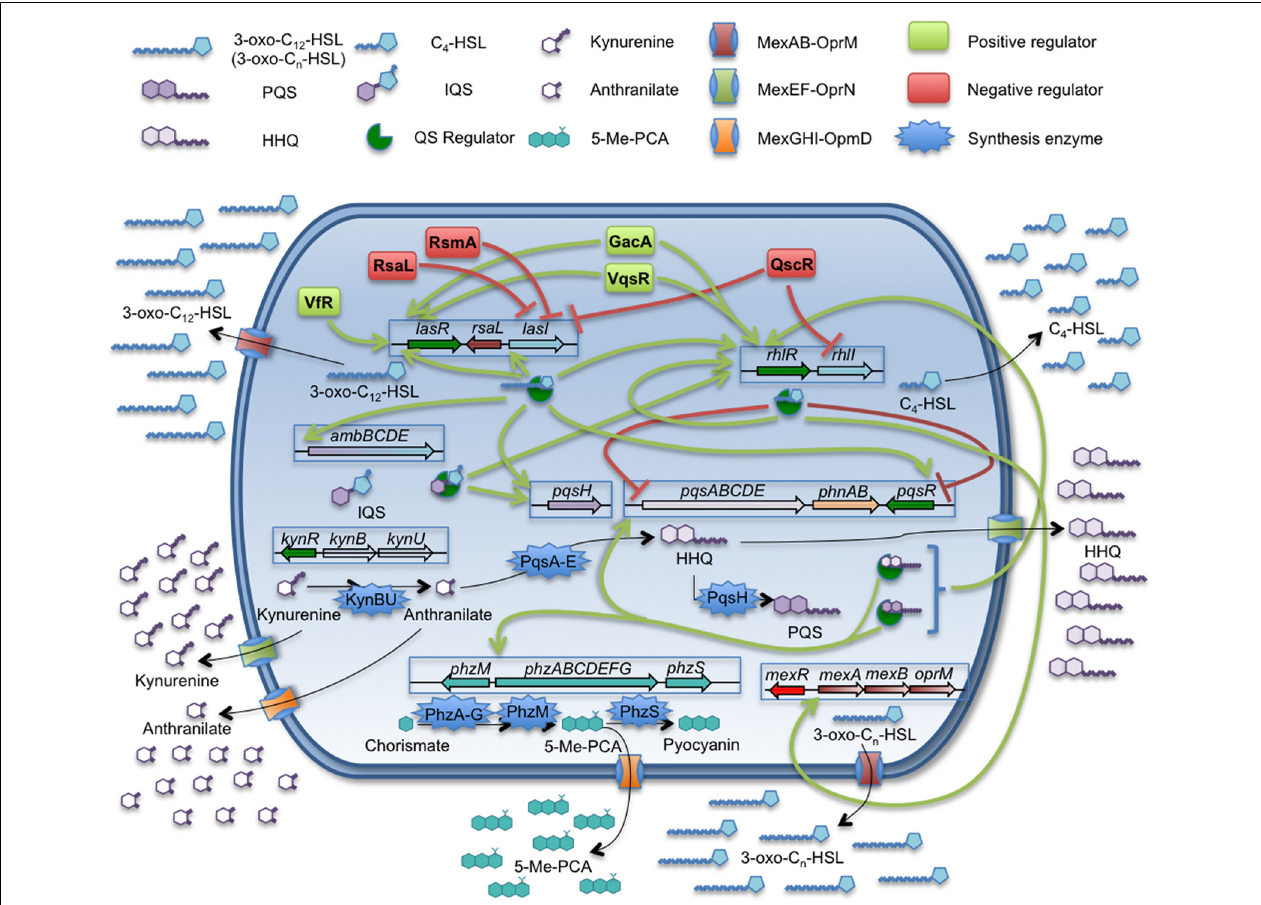
FIGURE 1 | Quorum sensing network and related efflux pumps in P. aeruginosa . The QS signals produced by P. aeruginosa are: 3-oxo-C 12 -HSL, C 4 -HSL, PQS/HHQ, and the recently discovered IQS. The figure sums up the complexity of the QS regulation network and the implications of MexAB-OprM, MexEF-OprN, and MexGHI-OpmD efflux pumps on the extrusion of QSSMs, their precursors or molecules which expression is QS-regulated. Despite of C 4 -HSL is able to cross the cell envelopes by free diffusion, the expression of mexAB-oprM is triggered in presence of this autoinducer. Further, this efflux pump is able to extrude 3-oxo-C 12 -HSL and others related 3-oxo-C n -HSL. The MexEF-OprN system is able to extrude HHQ and kynurenine, a precursor of 4-alkyl-quinolones, having an impact on the QS response. In the case of MexGHI-OpmD, its role has been recently linked to the extrusion of 5-Me-PCA, a precursor of the phenazine pyocyanin, whose production is induced upon the QS response. However, it has been proposed that this system is able to efflux anthranilic acid, another AQs intermediate, which is toxic for the cell at high concentrations. P. aeruginosa is a good example for the potential role of efflux systems in modulating the cell-to-cell communication